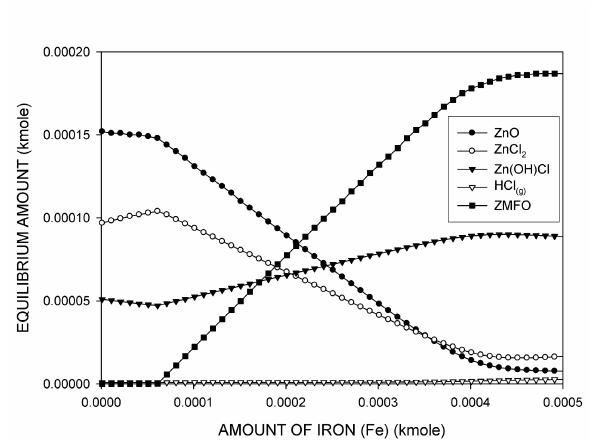
Figure 3(d). Effect of the amount of oxygen on the equilib- rium amounts of the zinc-containing species and gaseous HCl for the Zn-Fe-Mn-O-H-C-Cl system.